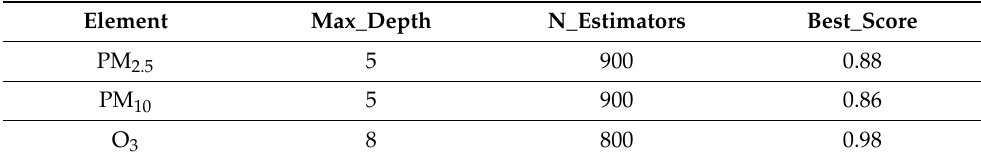
Table 4. GBDT Optimal parameters.